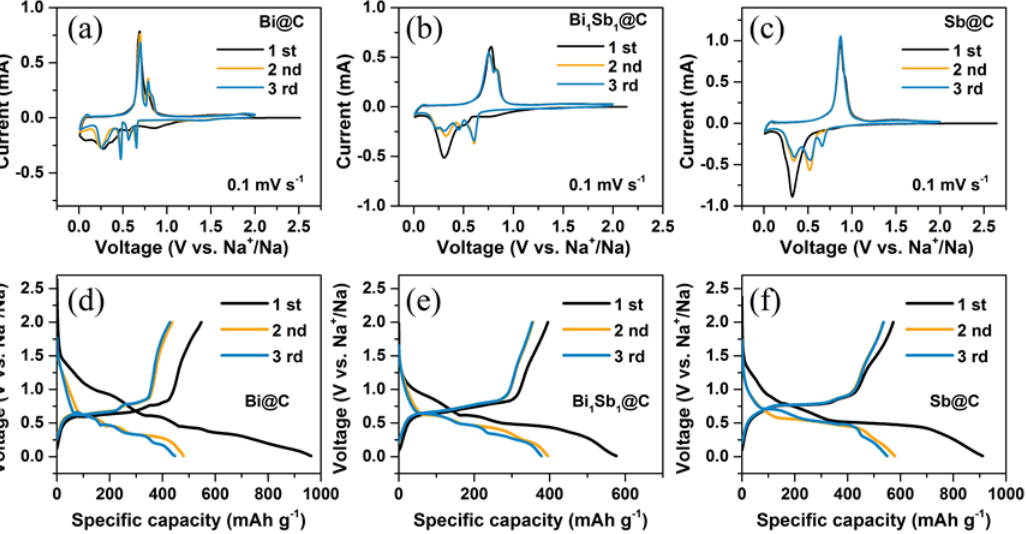
Figure 3. ( a – c ) Initial three cycles of CV curves and ( d – f ) the voltage curves of Bi@C, Bi 1 Sb 1 @C,